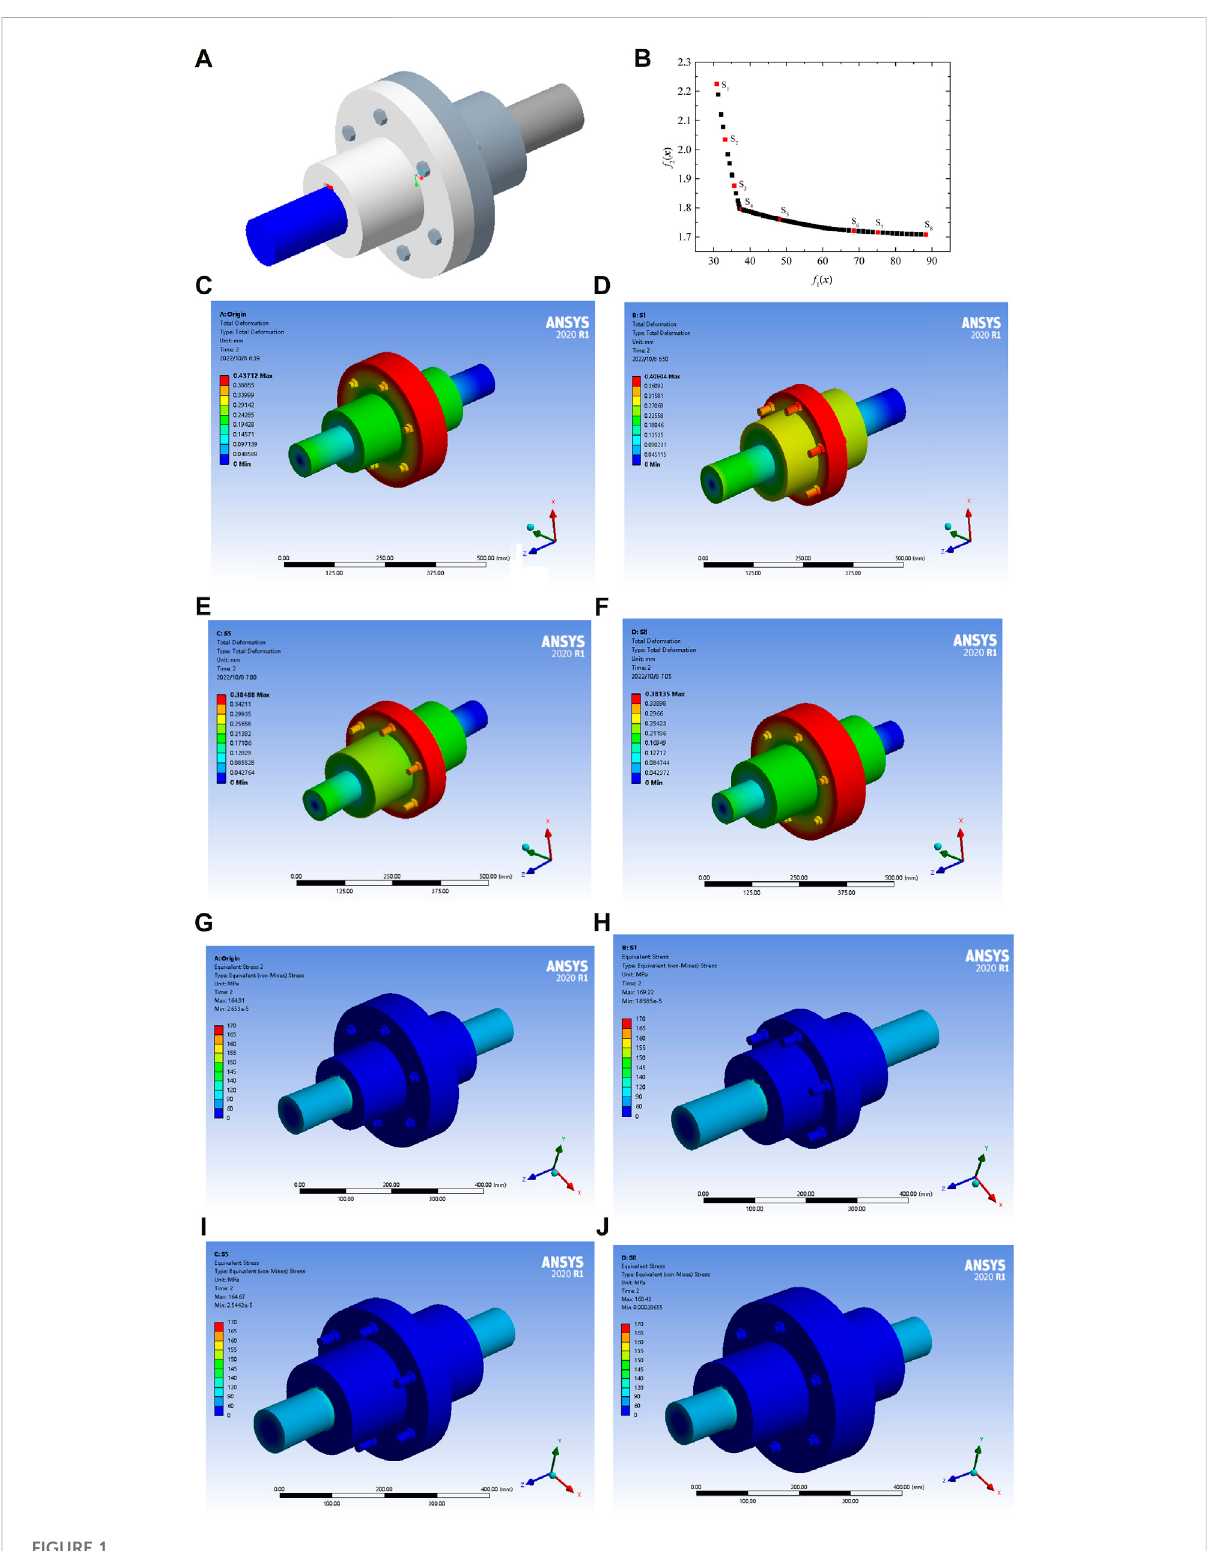
FIGURE 1 (A) Three dimensional model of fl ange coupling; (B) Pareto curve; (C) Total deformation of origin design; (D) Total deformation of solution S1; (E) Total deformationofsolutionS5; (F) Total deformationofsolutionS8; (G) Equivalent stressoforigin design; (H) EquivalentstressofsolutionS1; (I) Equivalent stress of solution S5; (J) Equivalent stress of solution